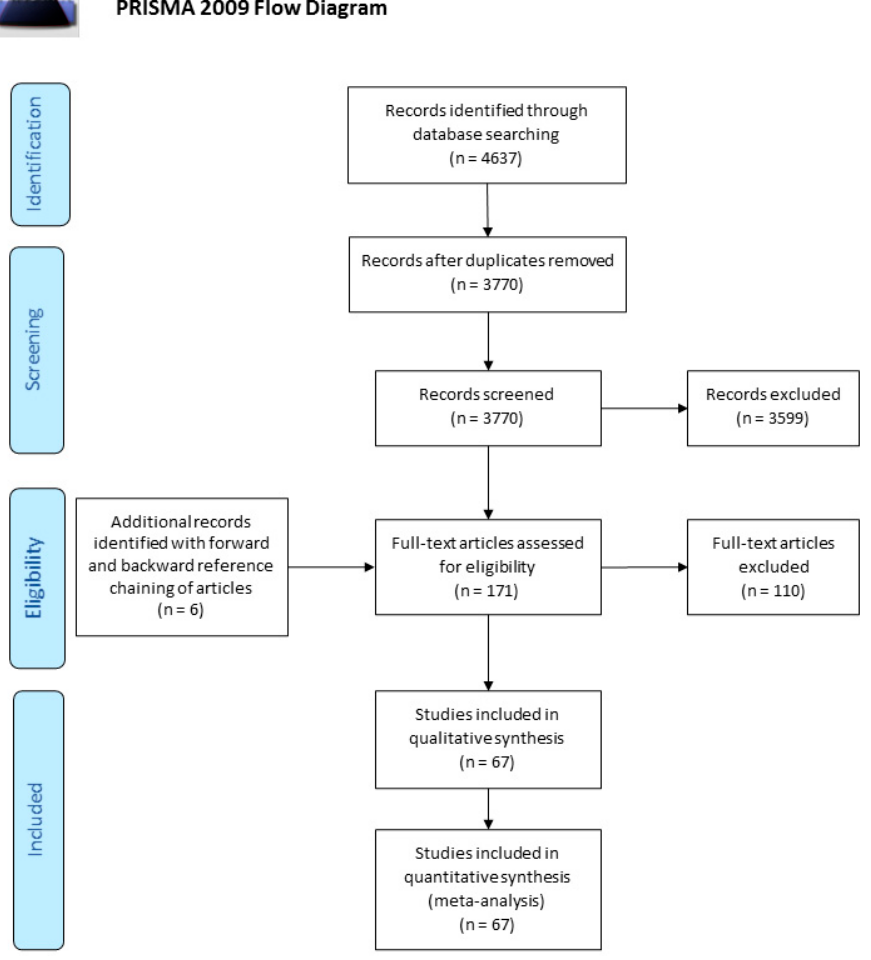
Figure 1. Preferred Reporting Items for Systematic Reviews and Meta-Analyses (PRISMA) flowchart.